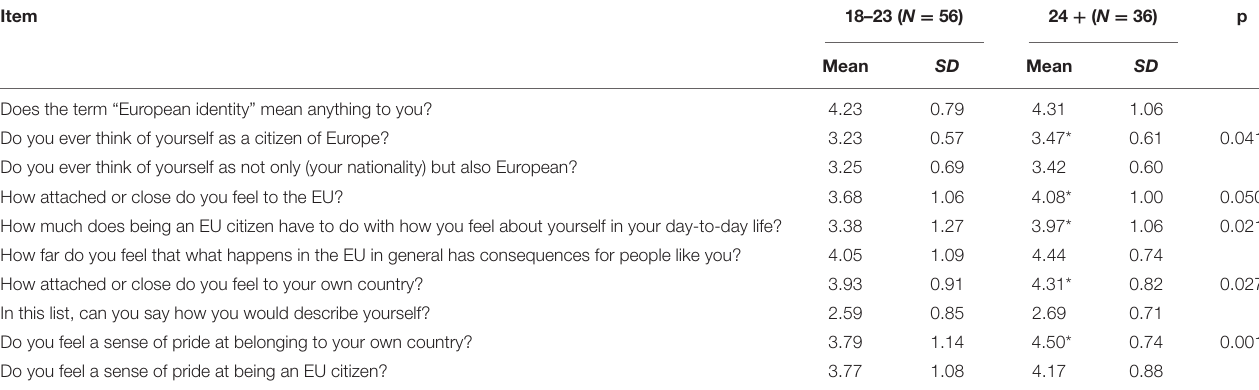
TABLE 4 | Students’ perceptions of European identity after the intervention (age groups).